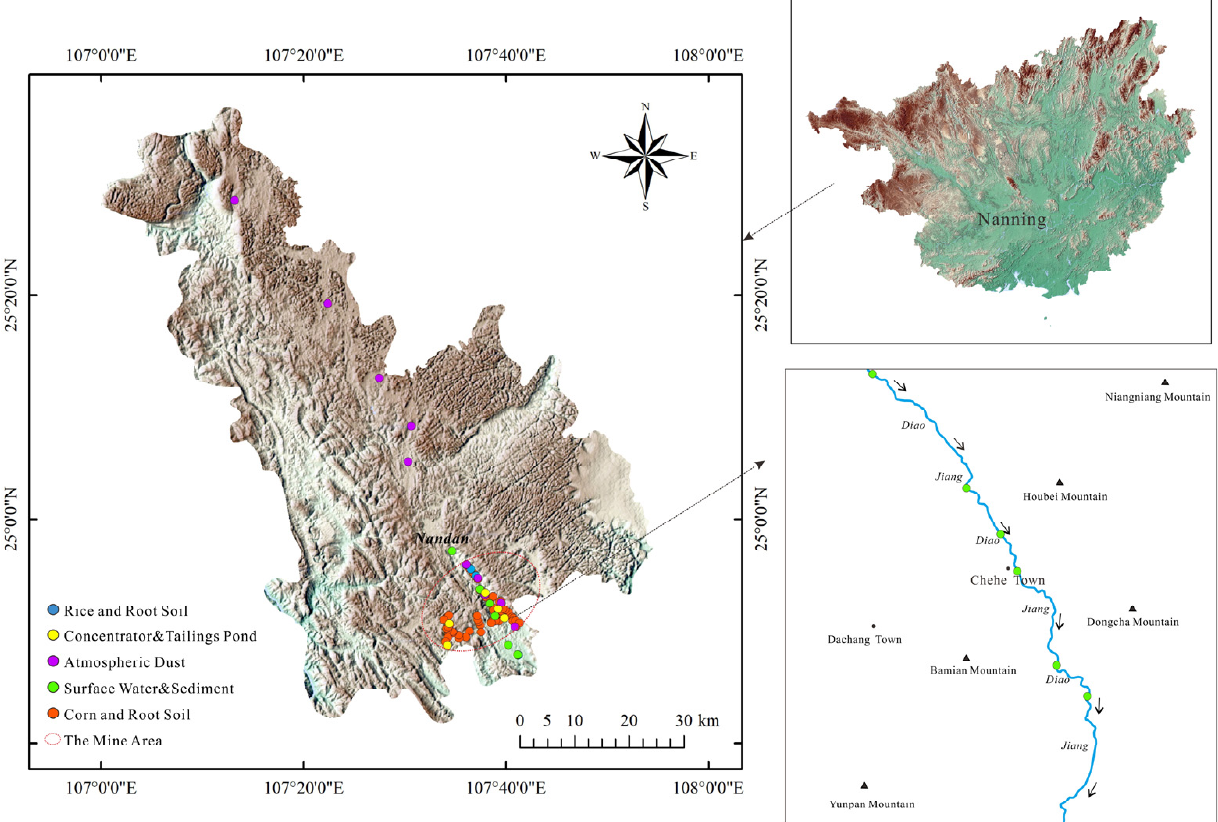
Figure 1. Distribution of sample locations.